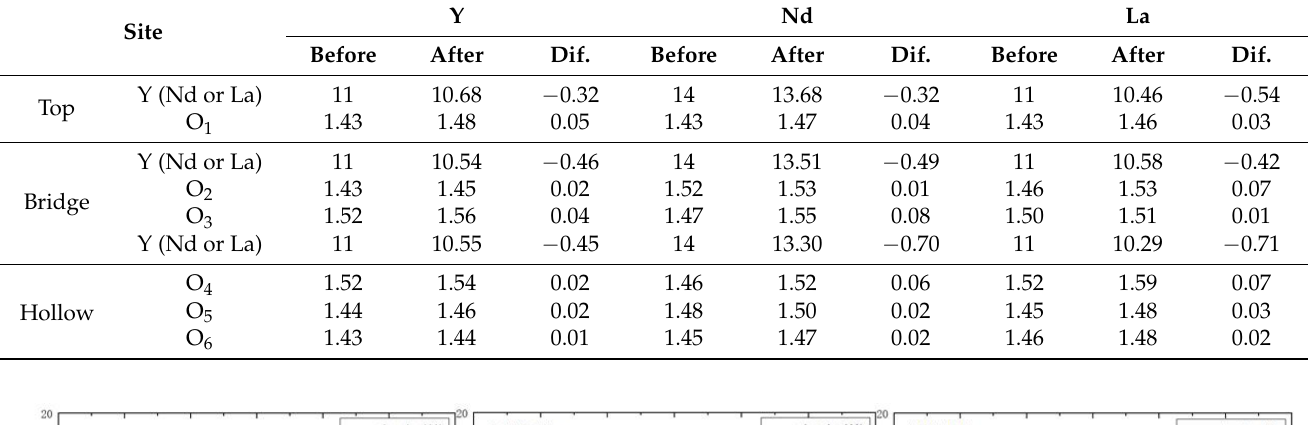
Table 4. Change in Bader’s charge for the REE adatoms and O atoms on the (001) surface of kaolinite. (Dif. = After − Before, — > (+) win e − , ( − ) lost e − ).